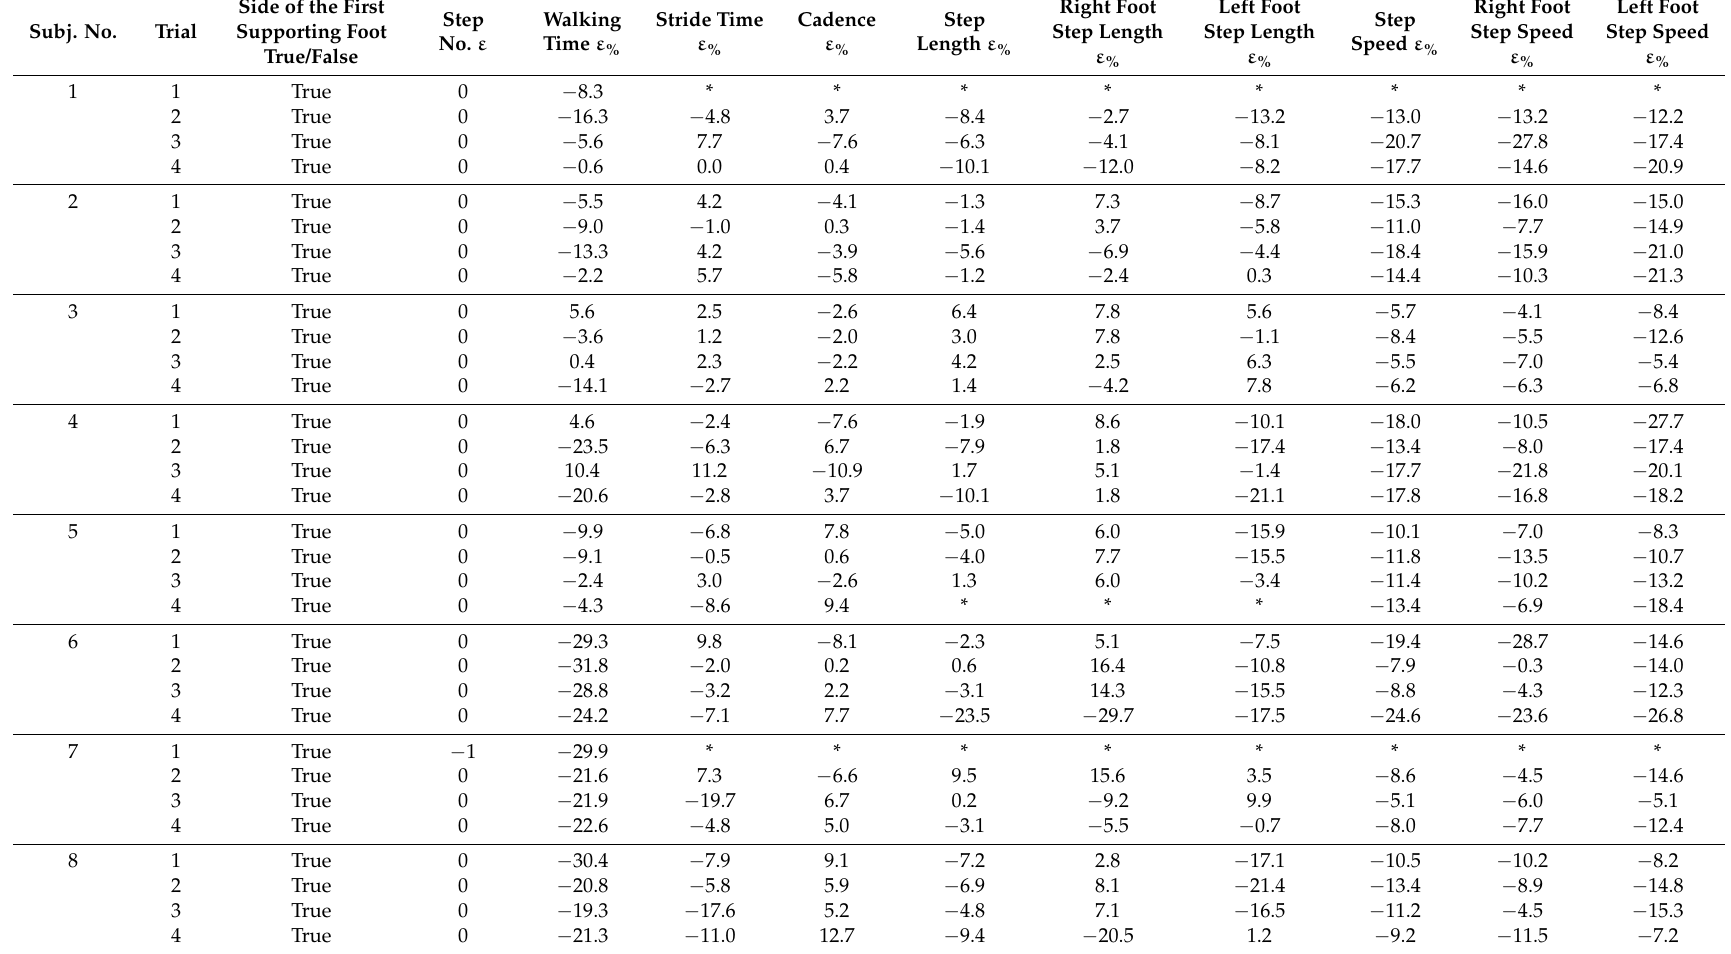
Table 3. Novel system validation: comparison between gold standard GA results and wearable system data (* GA data corrupted/not coherent. ε error.).